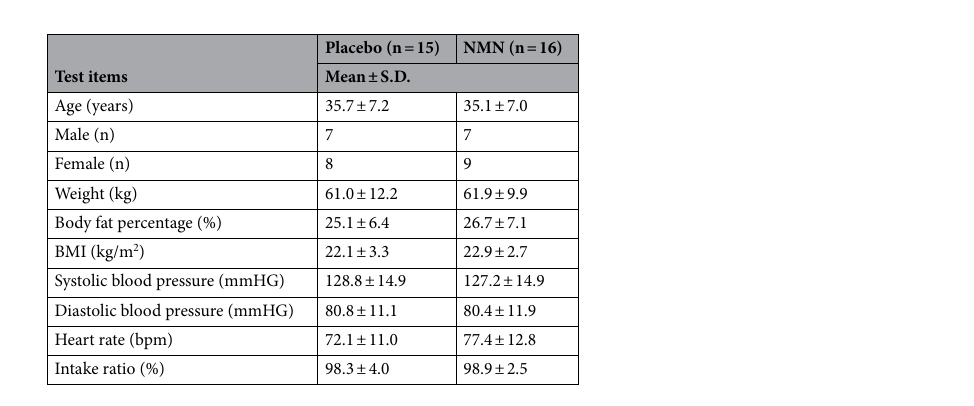
Table 3. Subject characteristics and intake ratio. BMI body mass index, S.D. standard deviation.